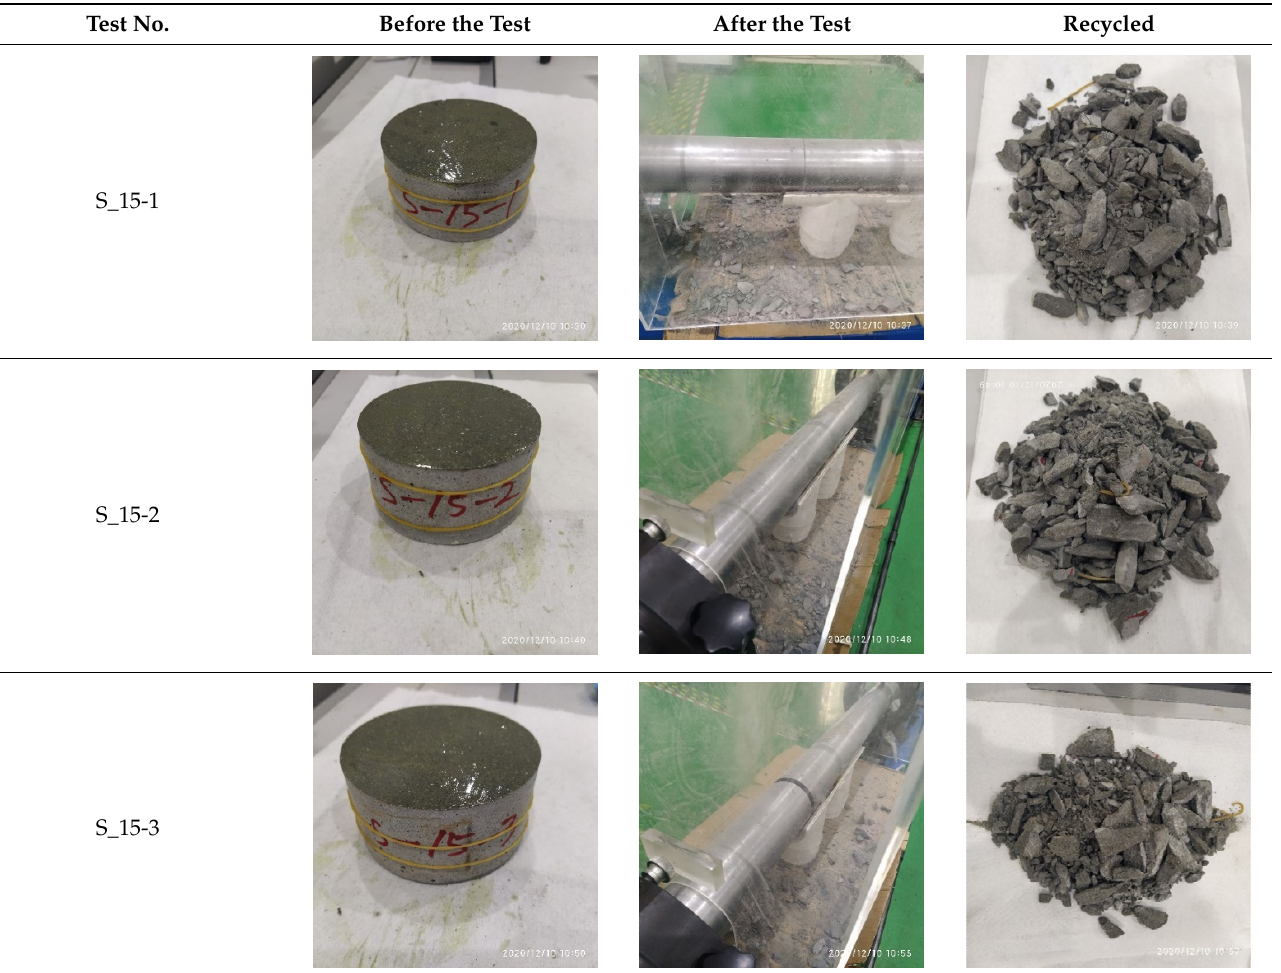
Table 5. Test results at an impact velocity of 15 m/s.